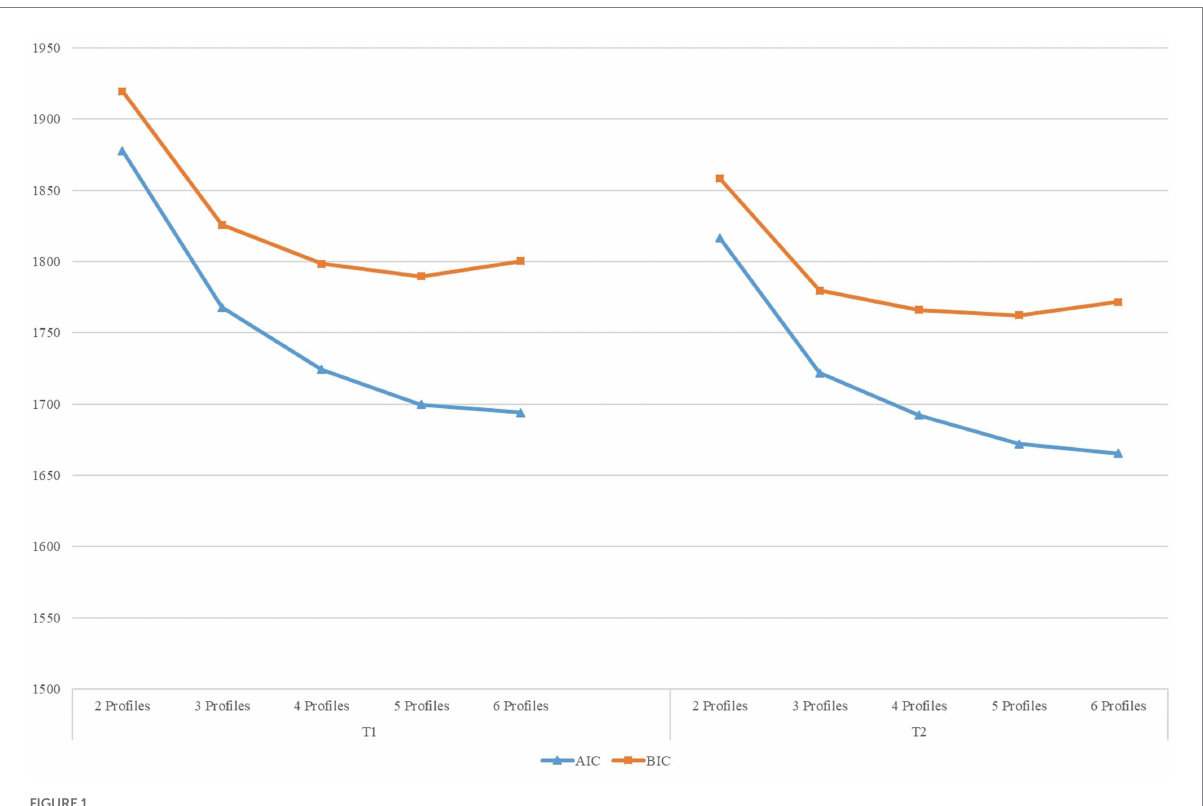
FIGURE 1 Elbow plot for BIC and AIC in determining profile solution. BIC, Bayesian information criterion; AIC, Akaike information